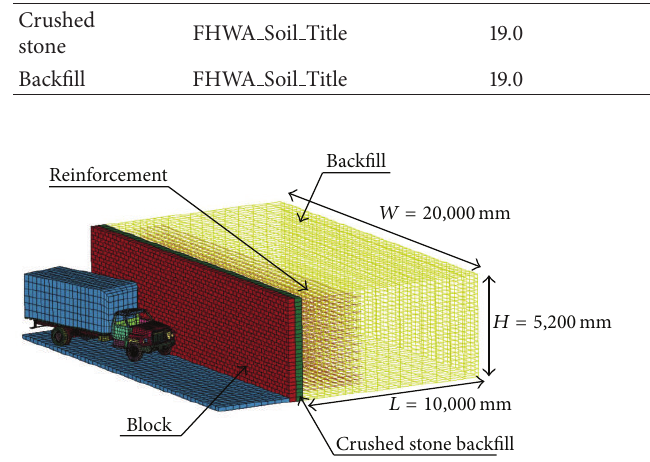
Figure 3: Collision analysis model of reinforced retaining